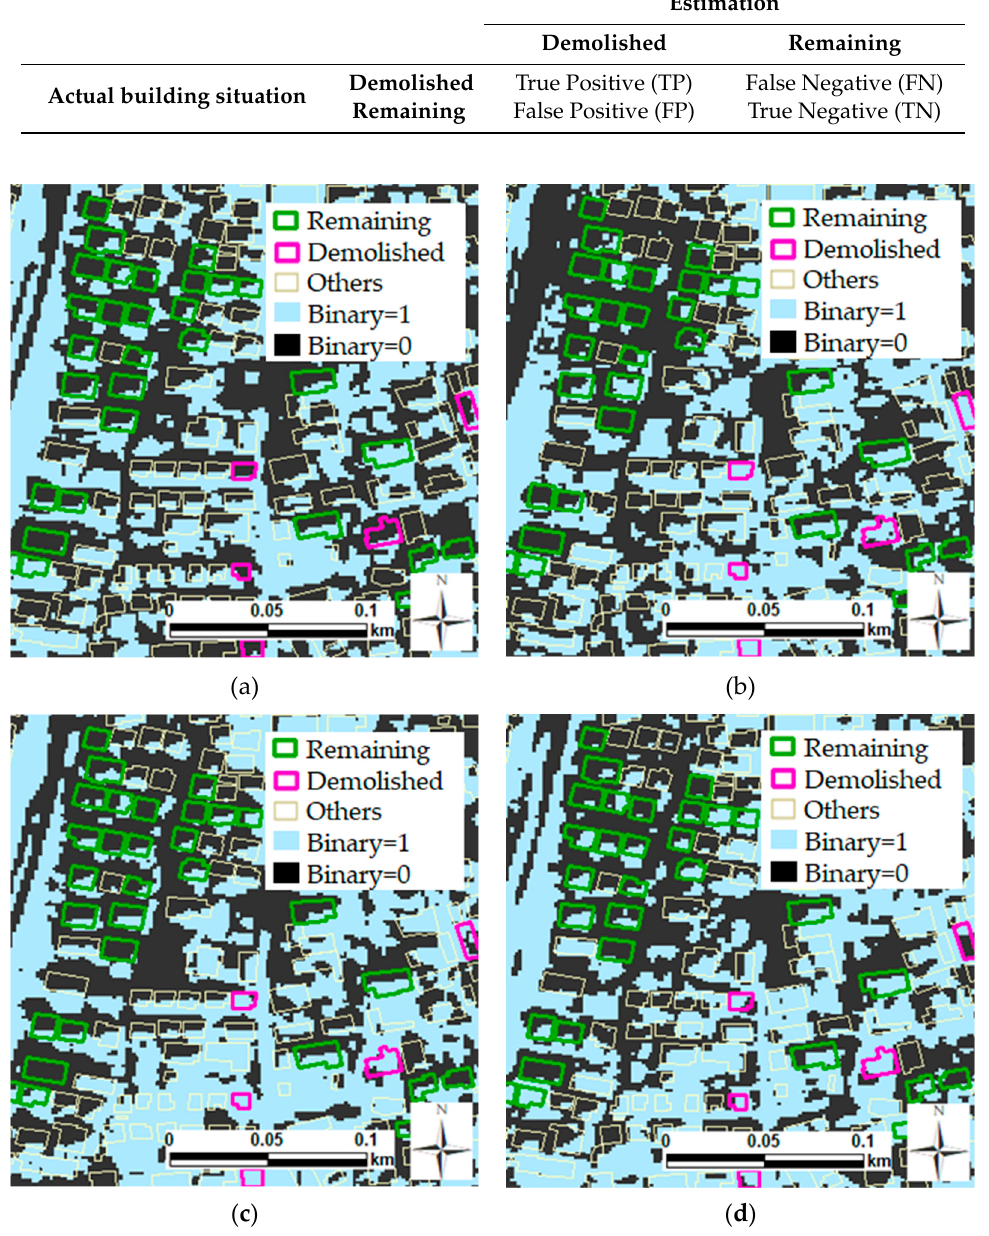
Figure 11. Binary images calculated from: ( a ) 20 March 2016; ( b ) 29 July 2016; ( c ) 1 January 2017; and ( d ) 25 March 2018.